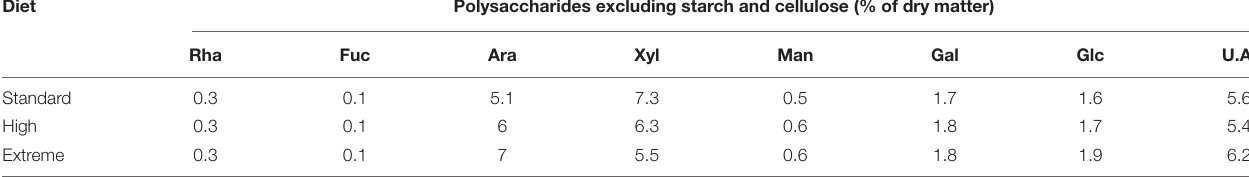
TABLE 2 | Monosaccharide composition analysis of the three diets, including the content of Rha (rhamnose), Fuc (fucose), Ara (arabinose), Xyl (xylose), Man (mannose), Gal (galactose), Glc (glucose), and U.A. (uronic acid).